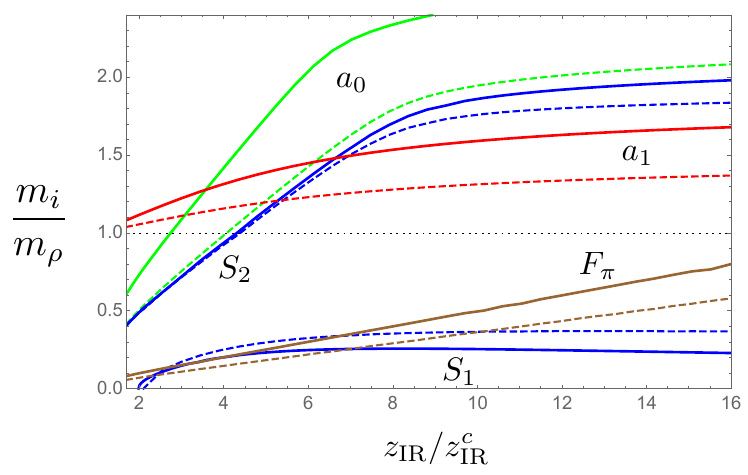
Figure 6 . Masses of the two lightest singlet scalars, S 1 and S 2 , lightest adjoint scalar ( a 0 ), lightest axial-vector ( a 1 ) and F (cid:25) , normalized to the vector mass for ^ m 2 ^ (cid:20) 2 = 1 (4) for the solid (dashed)